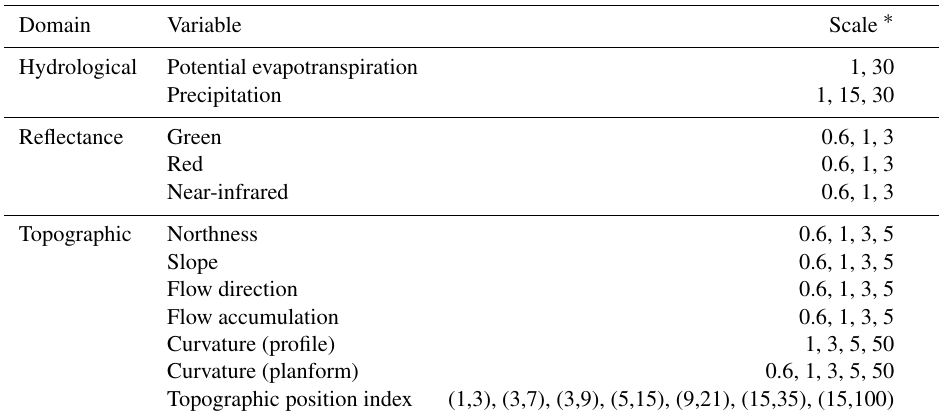
Table 2. Predictor variables used for machine learning models. Domain Variable Scale ∗ Hydrological Potential evapotranspiration 1, 30 Precipitation 1, 15, 30 Reflectance Green Red Topographic